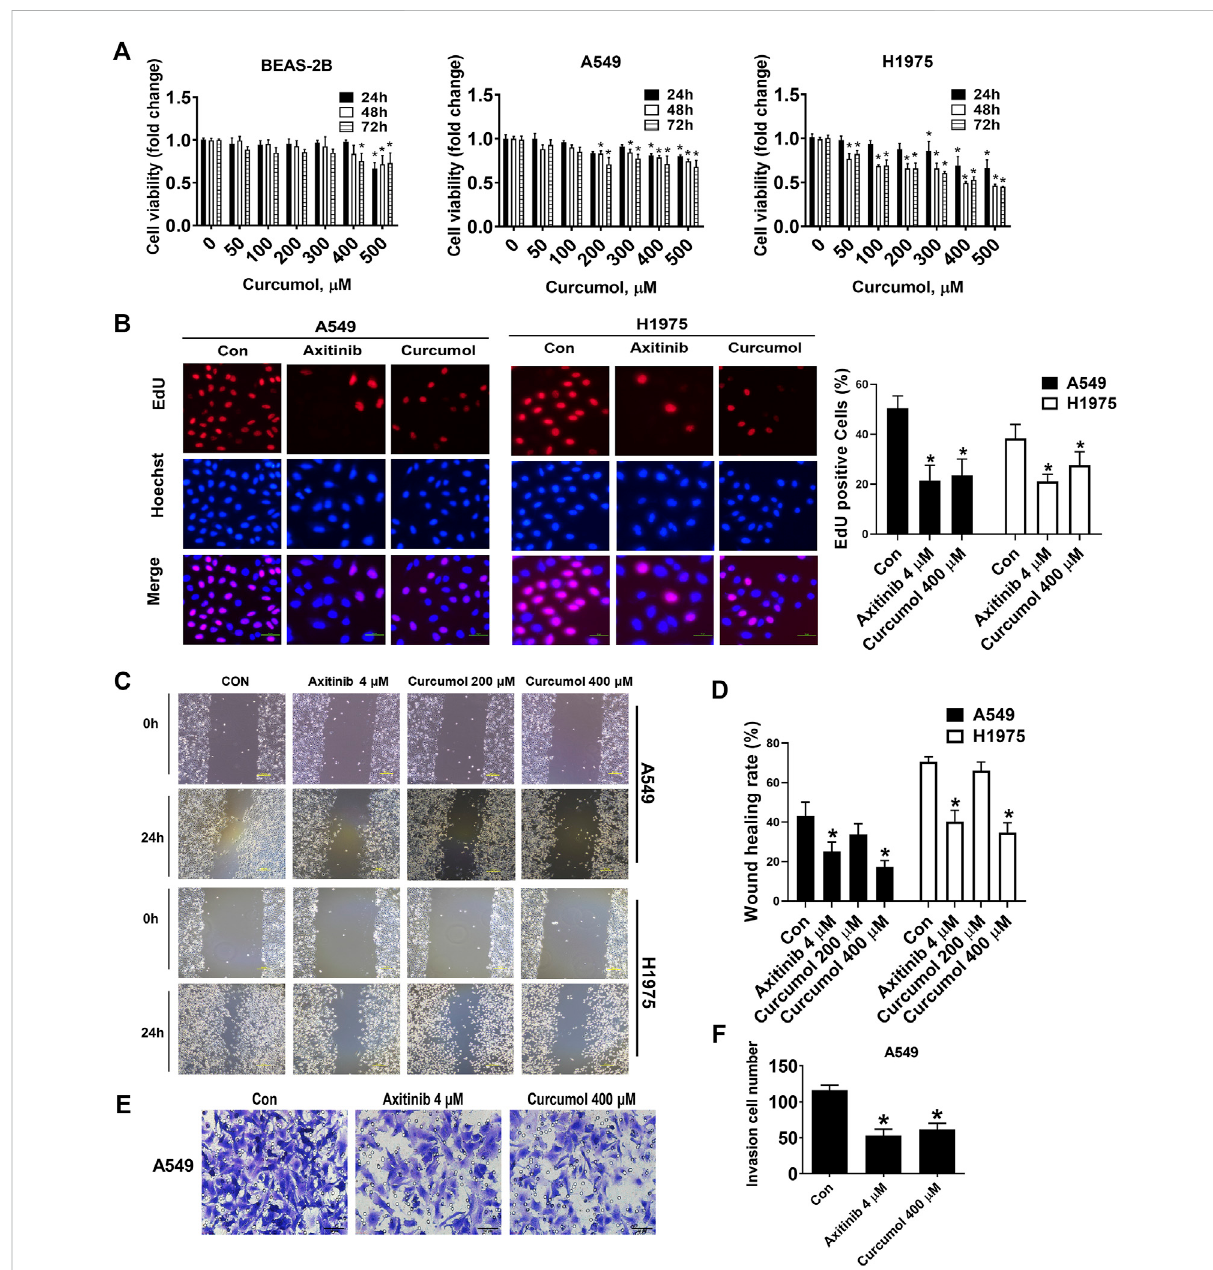
FIGURE 1 Curcumol attenuated NSCLC cells proliferation, migration, invasion capabilities. (A) Inhibitory effect of Curcumol on the cell viability of BEAS- 2B, A549, H1975 cells at 24 h, 48 h and 72 h by MTT analysis. (B) A549 and H1975 cells were treated with Axitinib (4 μ M) or Curcumol (400 μ M) for 24 h, followed by EdU cell proliferation assay. Scale bar, 50 μ m. (C , D) A549 and H1975 cells migration measured by wound healing assay. Scale bar, 200 μ m. (E , F) A549 cells invasion ability examined by Transwell assays. Scale bar, 50 μ m. The data are generated from fi ve independent experiments (n = 5) and showed as mean ± SD. * p < 0.05, compared with control (0 μ M or Con). NSCLC, non-small cell lung